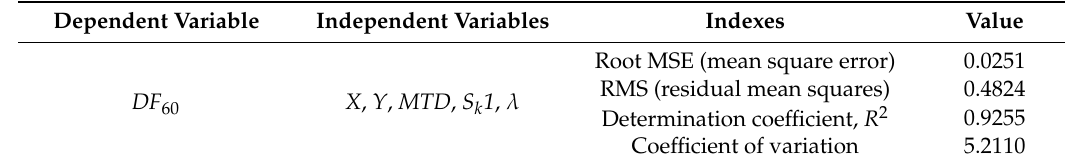
Table 6. Summary results of final DF 60 model.